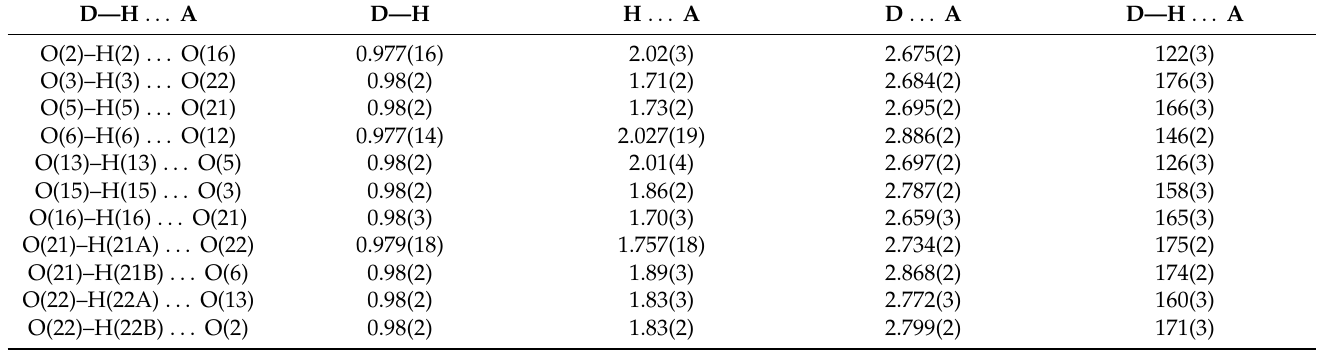
Figure 2. ( Left ) Hydrogen-bonding pattern between the four independent molecules. ( Right ) Larger portion of the structure showing all 11 distinct hydrogen bonding interactions. Table 1. Hydrogen bonding parameters for 1 (Å , °).